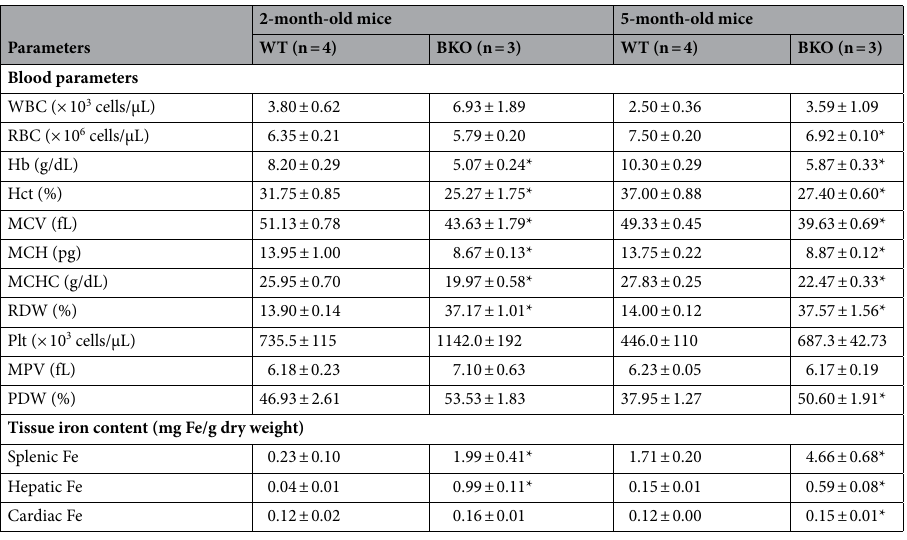
Table 1. Blood counts of 2- and 5-month-old male BKO and WT mice. Values are mean ± SE. WT wild-type, BKO hemizygous β-globin knockout thalassemia, WBC white blood cell count, RBC red blood cell count, Hb hemoglobin concentration, Hct hematocrit, MCV mean corpuscular volume, MCH mean corpuscular hemoglobin, MCHC mean corpuscular hemoglobin concentration, RDW red cell distribution width (variation in red blood cell size or volume), Plt Platelet count, MPV mean platelet volume, PDW platelet distribution width. * P < 0.05 BKO vs. age-matched WT mice. The tissue iron contents were analyzed by chromogenic